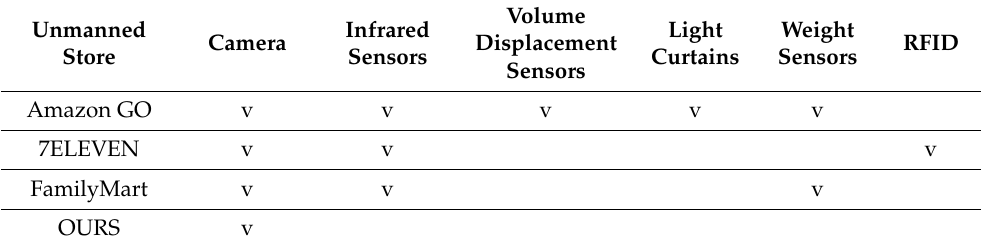
Table 7. Cost analysis of this paper and other unmanned